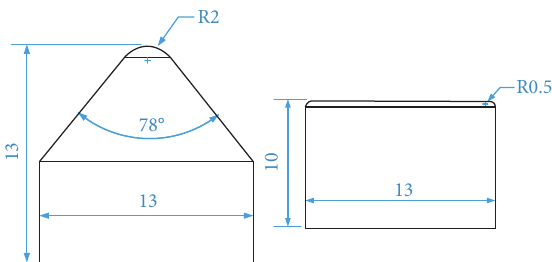
Figure 2: The geometric dimensioning of the cutter.